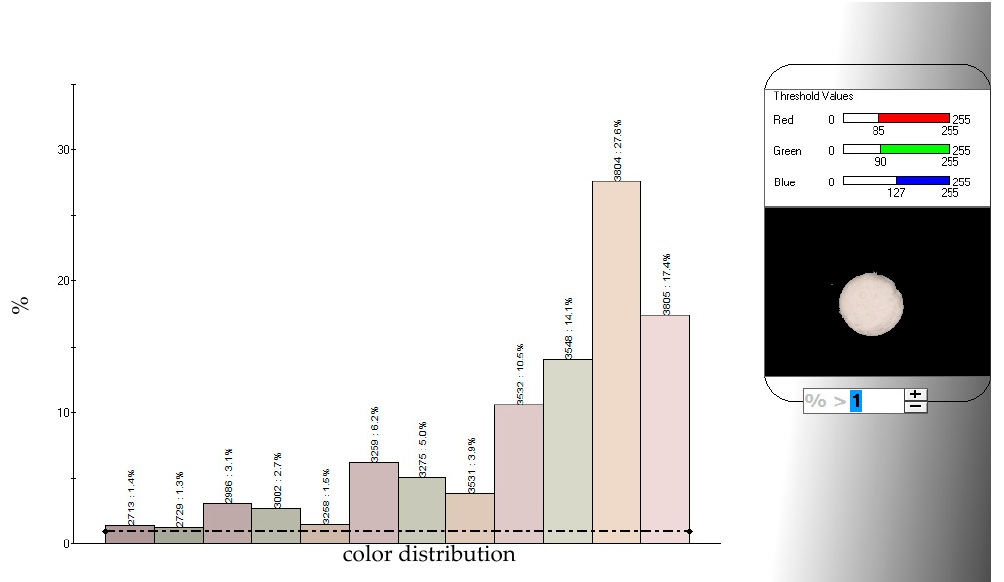
Figure 2. Detailed colour analysis of white garlic from conventional cultivation (G) using the instrumental method (“electronic eye”).